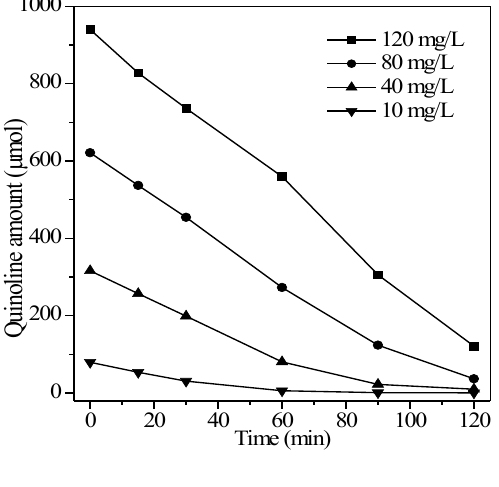
Figure 5. Effect of the initial quinoline concentration on the photocatalytic degradation. Conditions: T = 290 K, flow rate = 0.35 L/min, pH = 6.7, and the maximum irradiation